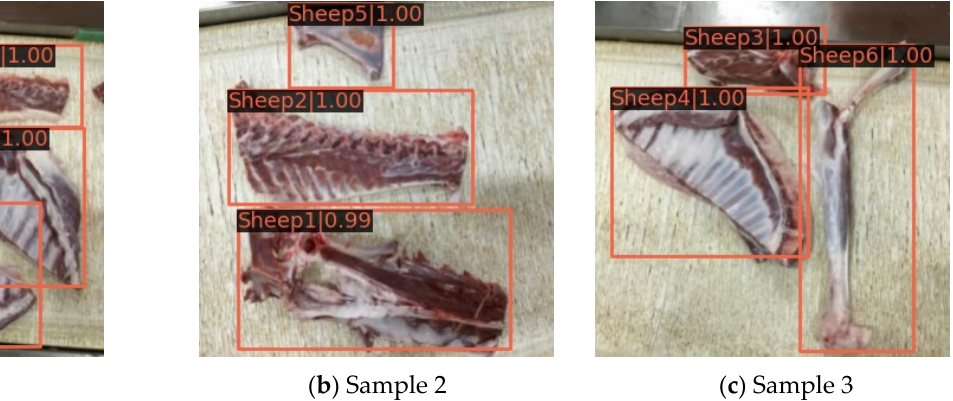
Figure 10. Partial detection results of the model based on Swin-T mutton multi-parts classification detection.